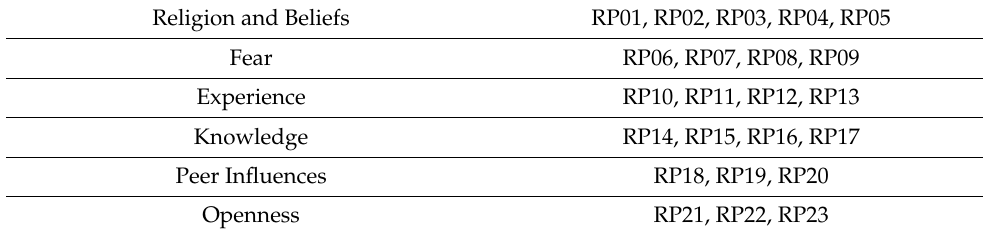
Table 2. Dimensions of Risk Perception RP and